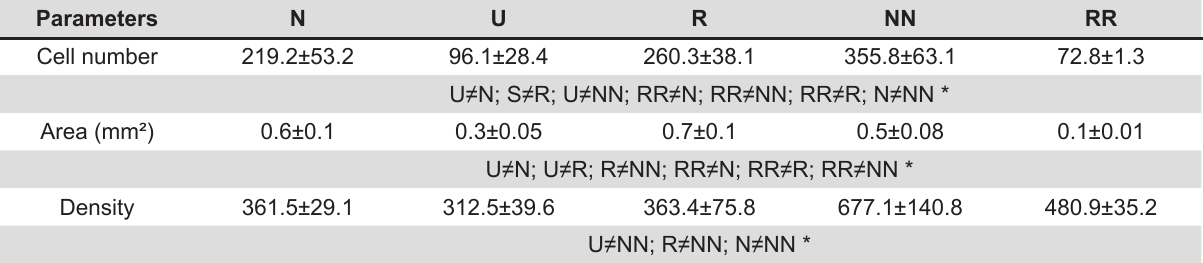
Table 3- Mean (± SD) of the number of immunoreactive insulin receptor (IR) cells; area of the CP cartilage and cell density in the different groups. SD=Standard Deviation